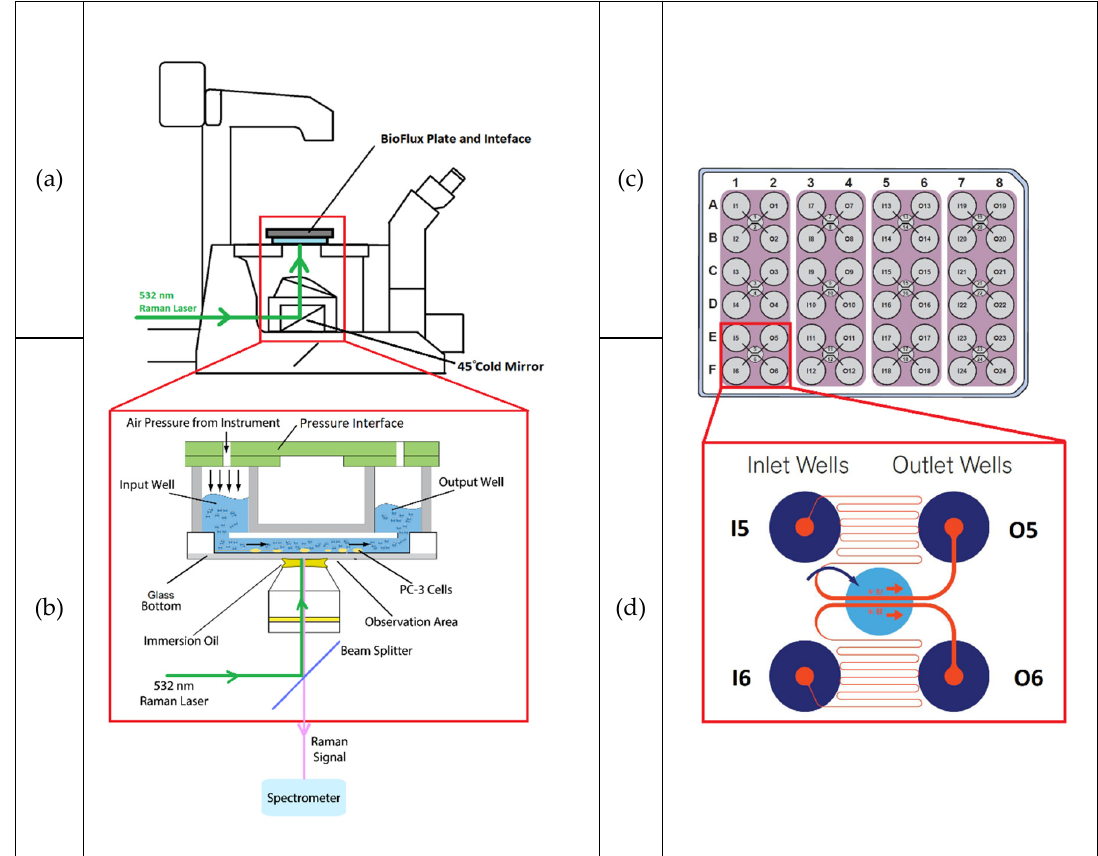
Figure 4. Schematic diagram of the system layout and equipment configuration. ( a ) Side view of the configuration of the microscope and the microfluidic plate with the plate connecting to the main body of the BioFlux system. Green arrow showing the inlet Raman laser path to the sample stage. The area in the red rectangle is expanded in ( b ), which shows the configuration of the measuring unit (BioFlux interface, the well plate, the microscope objective and a simplified light path diagram). ( c ) Top-down view of the BioFlux 48-well plate configuration. ( d ) Layout of the microfluidic channels (one observation unit, showing two pairs of channels, only one pair is used at a time). In the top pair the media and FA would flow from the inlet well (designated I5) through the hairpin microfluidic channel to the observation window containing the cells, then back out to the outlet well (designated O5). The Raman beam would be focused on the cells in the top channel in the observation window.